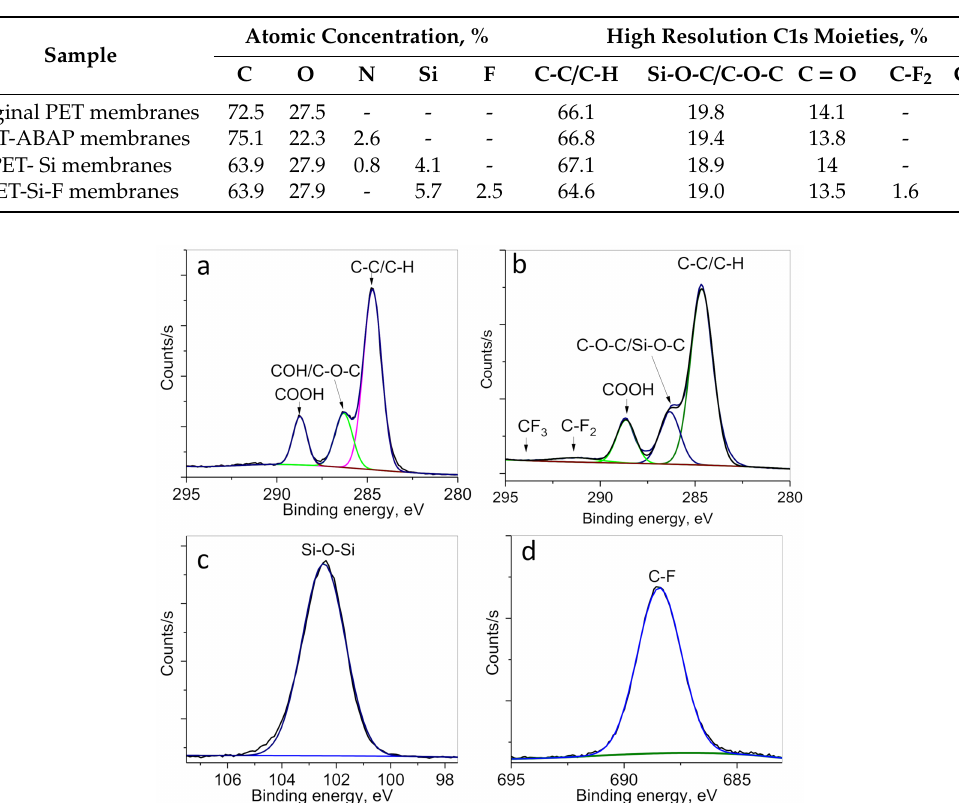
Table 3. XPS surface composition of the samples.